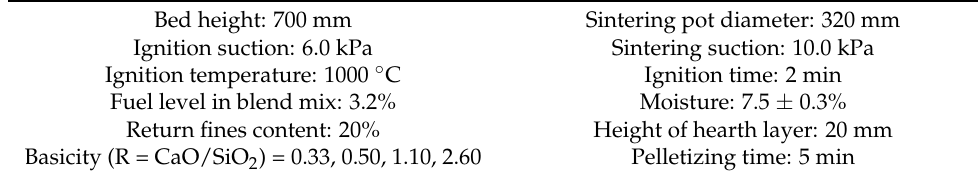
Table 4. Parameters of the sintering test.